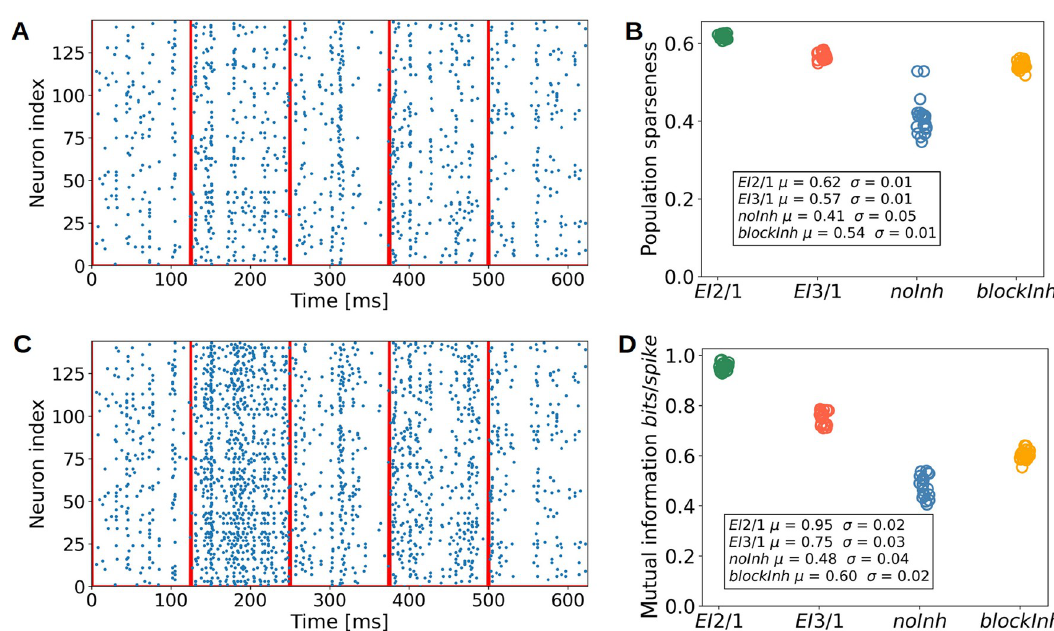
Fig 9. Sparse and efficient input representations through inhibitory processing. A Raster plot of the excitatory population for the EI 2/1 model, same for the blockInh model C . Spikes are recorded on the same five natural image patches. The red lines show the stimulus onset. B Population sparseness for the EI 2/1, the blockInh , and the noInh model, averaged across 10.000 natural scene patches. Higher value represent a higher sparseness of population activity. D Mutual information in bits / spike for the same three models as in B . B and D show data from 20 independent simulations per model configuration. Note the more synchronous population activity in the noInh model ( C ), associated with reduced sparseness ( B ) and lower information content ( D ). While blocking inhibition post-learning in the blockInh model decreases sparseness only moderately, it considerably reduces the information per